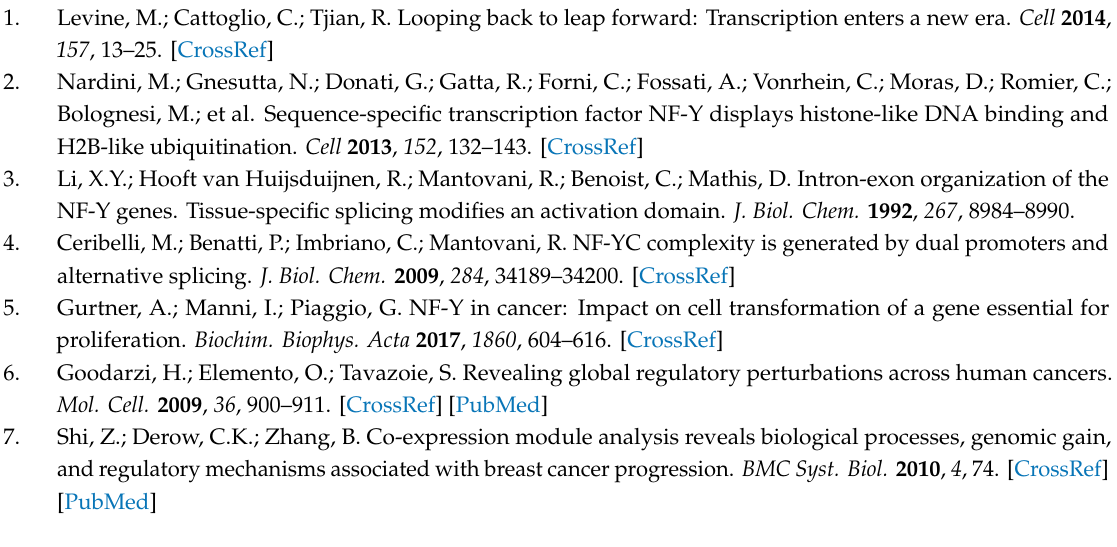
Figure S1: partitioning of GSE81089 data. A. Correlation plot B. PCA. A. Heatmap of signature genes expression across sample classified. Figure S2: splicing of NF-YC. Figure S3: expression of genes hallmarks for each subtype. Figure S4: Global NF-YA expression levels in LUSC subtypes. A. Comparison of relative NF-YA global levels in LUSC subtypes in microarray data. B. Global NF-YA levels in TCGA LUSC subtypes according to RNA-seq data. Figure S5: KOBAS analysis of commonly up-regulated genes in LUSC subtypes. Figure S6: analysis of commonly down-regulated genes in LUSC subtypes. A. Venn diagrams. B. Pscan analysis of promoter sequences of commonly down-regulated genes in all LUSC subtypes. C. KOBAS analysis of commonly down-regulated genes in all LUSC subtypes. Table S1: complete list of LUAD and LUSC samples of GSE81089. Table S2: lists of di ff erentially expressed genes in LUSC tumors vs normal tissues. Table S3: partitioning of LUSC tumors according to the four subtypes. Table S4: lists of di ff erentially expressed genes in LUSC subtypes